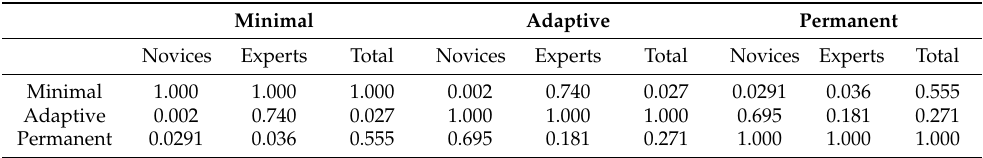
Table 4. p -values of pairwise comparisons using the Nemenyi post hoc test for the time participants took to perform the whole scenario.